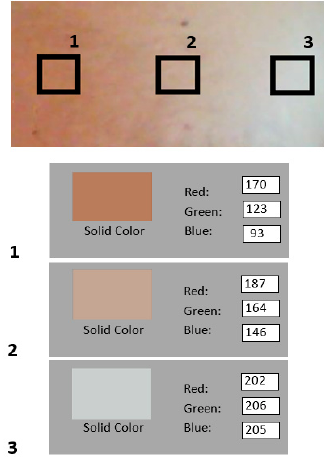
Figure 9. Comparison of intensities in RGB-channels, with different levels of illumination.